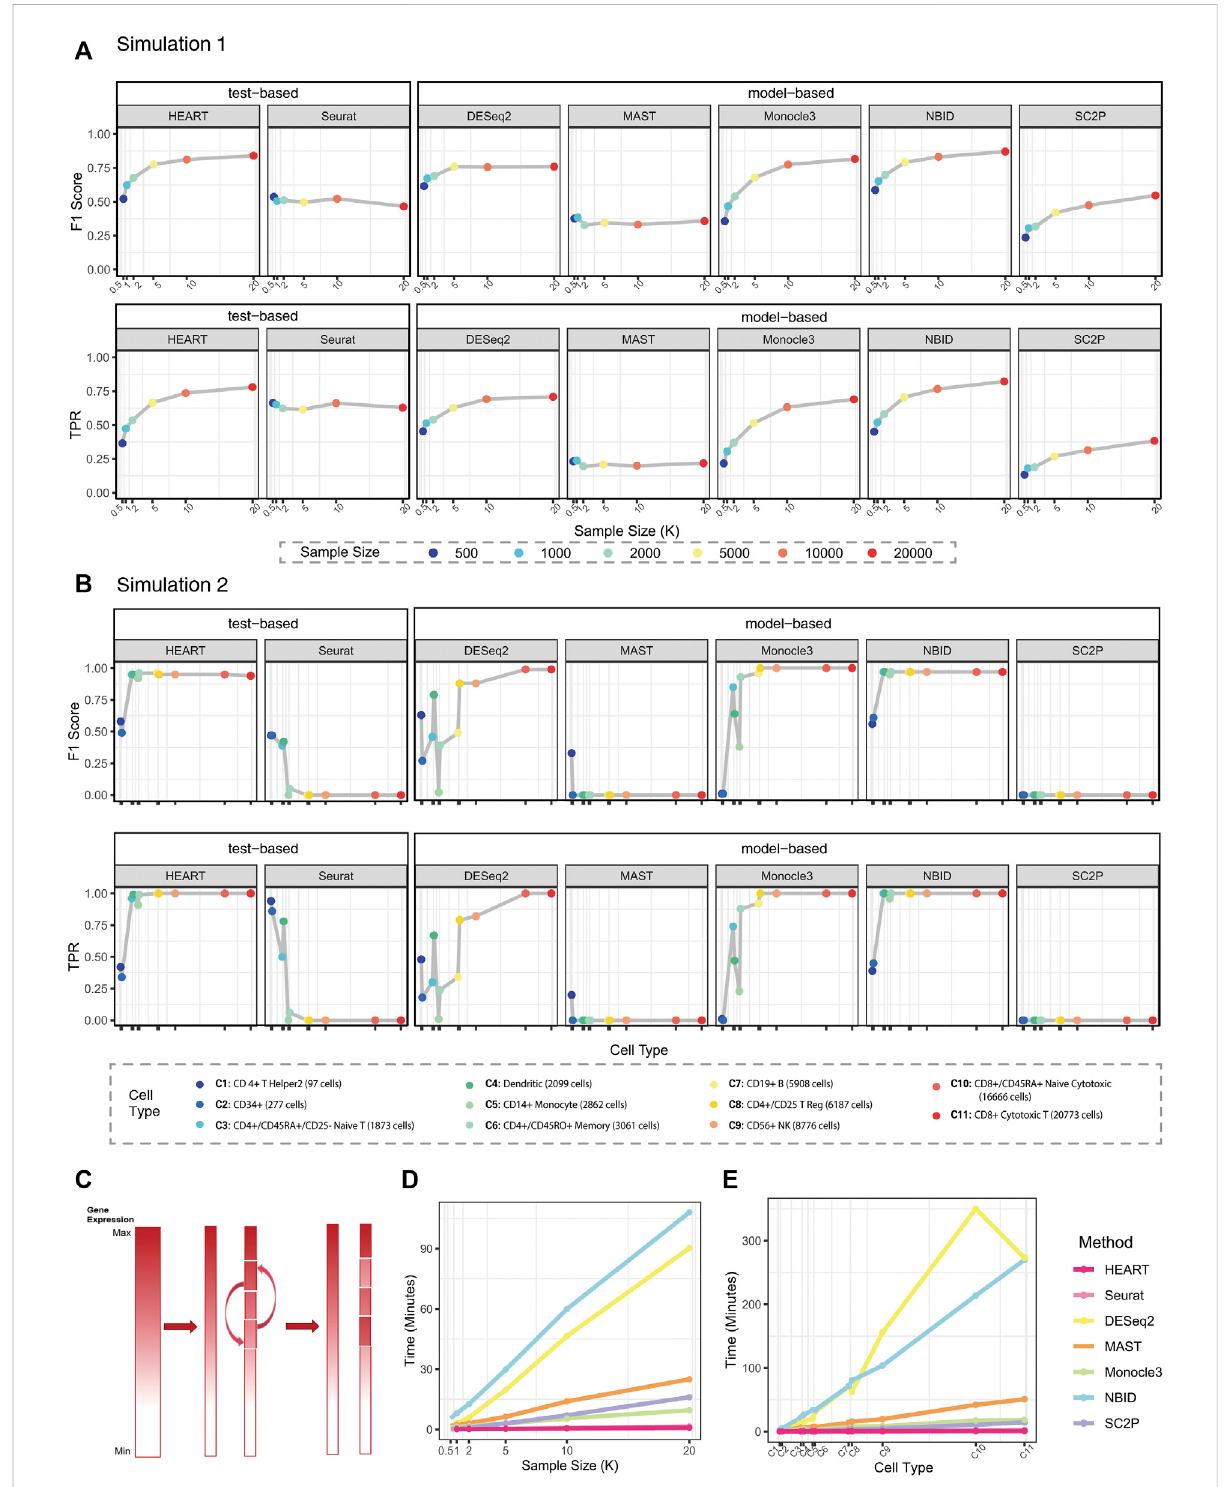
FIGURE 2 Simulationresults. (A) F 1 scoresandTPRsofallmethodsonsimulationdatasetsinSimulation1(de.factor=0.5).Plotsshow F 1 scores(y-axis)and TPRs (y-axis) for different sample sizes (x-axis) for different methods. Colorful points correspond to varied sample sizes. (B) F 1 scores and TPRs of all methodsonsimulationdatasetsinSimulation2(FC=2.5).Plotsshow F 1 scores(y-axis)andTPRs(y-axis)fordifferentsourcedata(x-axis)fordifferent methods. Colorful points correspond to different source datasets with different cells. (C) Semi-simulation data generation mechanism in Simulation 2. (D) and (E) Computational time of different methods for analyzing data with different sample sizes in Simulation1 and Simulation 2, respectively. The X-axis in (E) corresponds to the legend of (B)